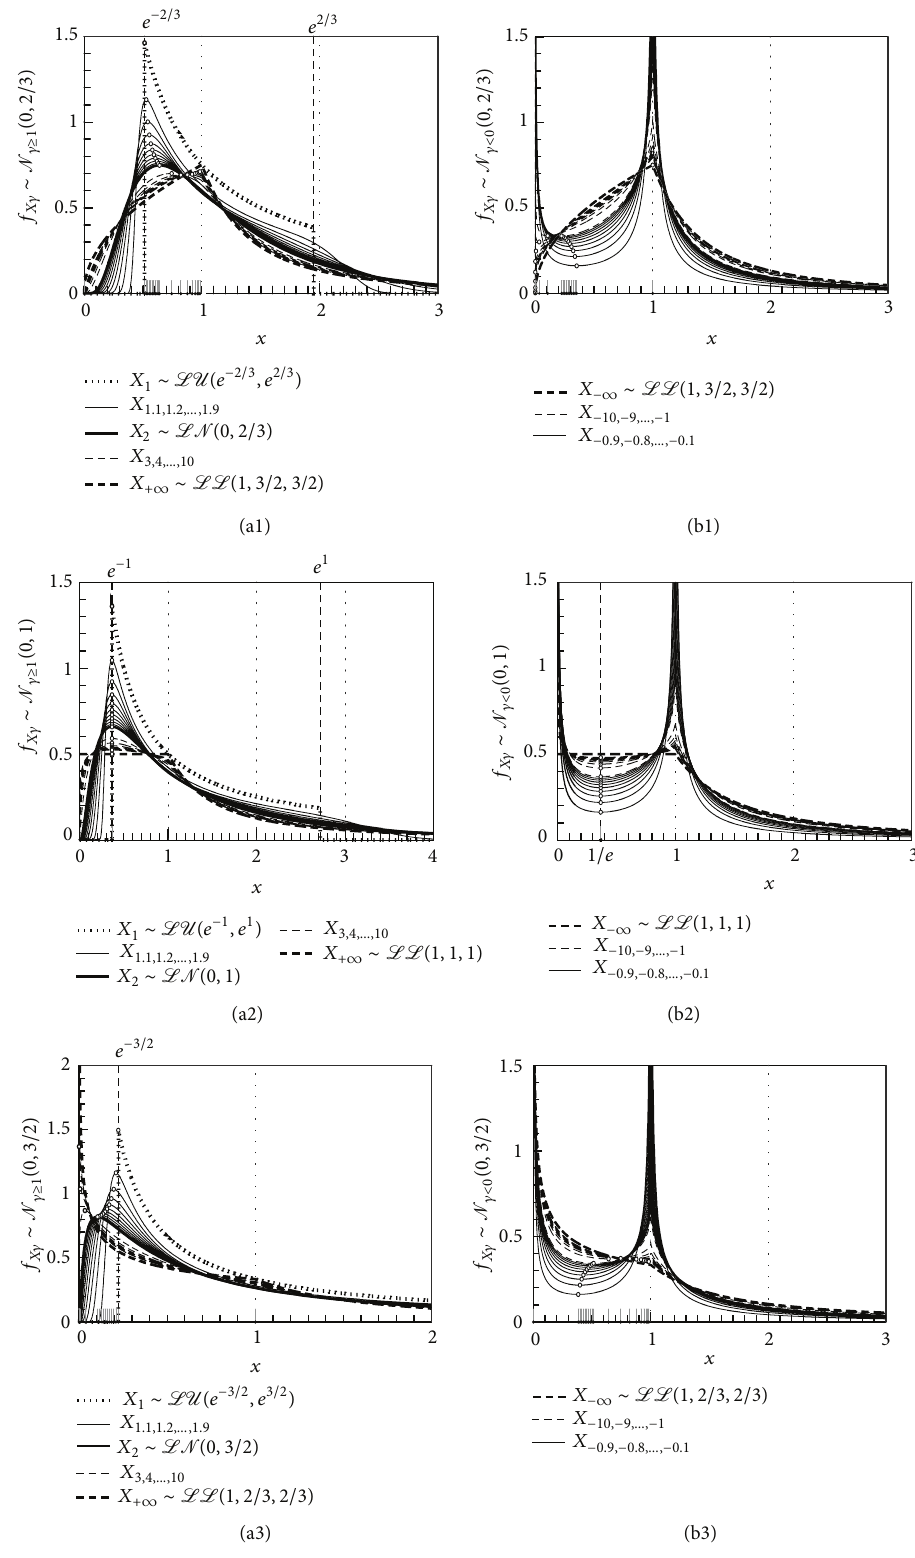
Figure 1: Graphs of the density functions 𝑓 𝑋 subfigures) 𝛾